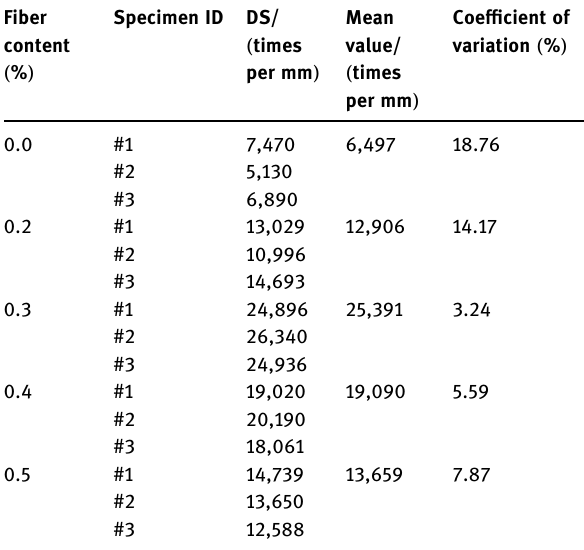
Table 5: Results of wheel rut tests Fiber